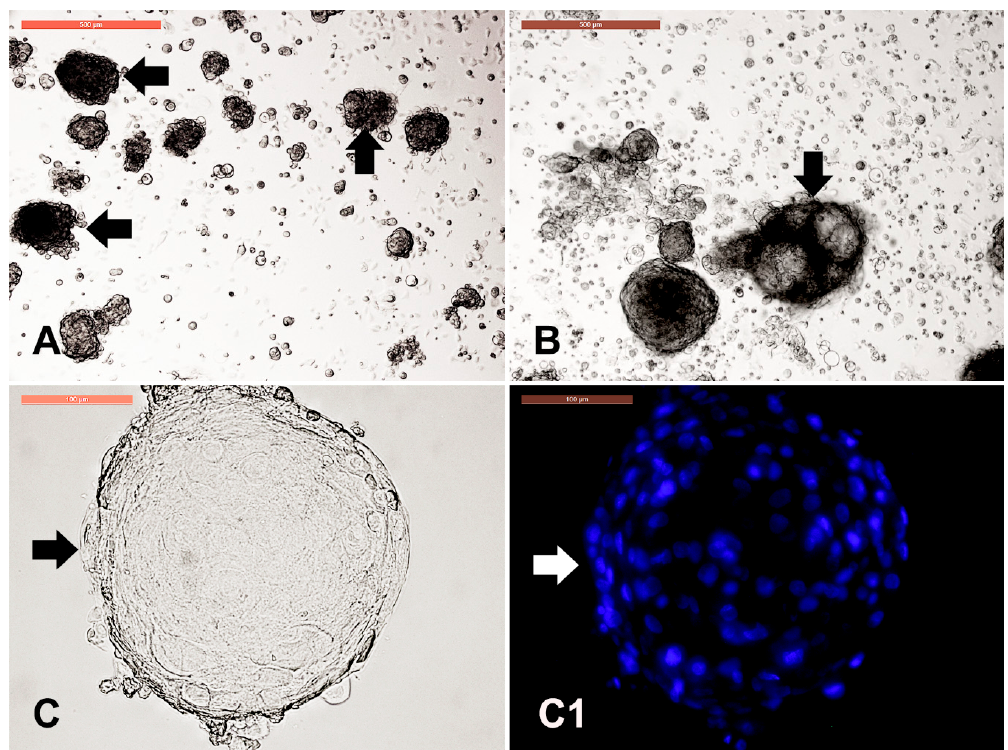
Figure 7. Dermal spheroid characterization. Cell clumps or dermal spheroids were clearly observed either in primary culture (P0) and in P1 in form of solid clumps (( A ), arrows) or fluid-filled clumps (( B ), arrow) with resemblance to the embryoid bodies as observed in pluripotent stem cell culture. Scale bar = 500 µm. Individual spheroid (( C ), arrow) were stained with Hoechst to reveal the uniform nuclear assembly of over than 100 cells to form the spheroids ( C1 ). Scale bar = 100 µm.